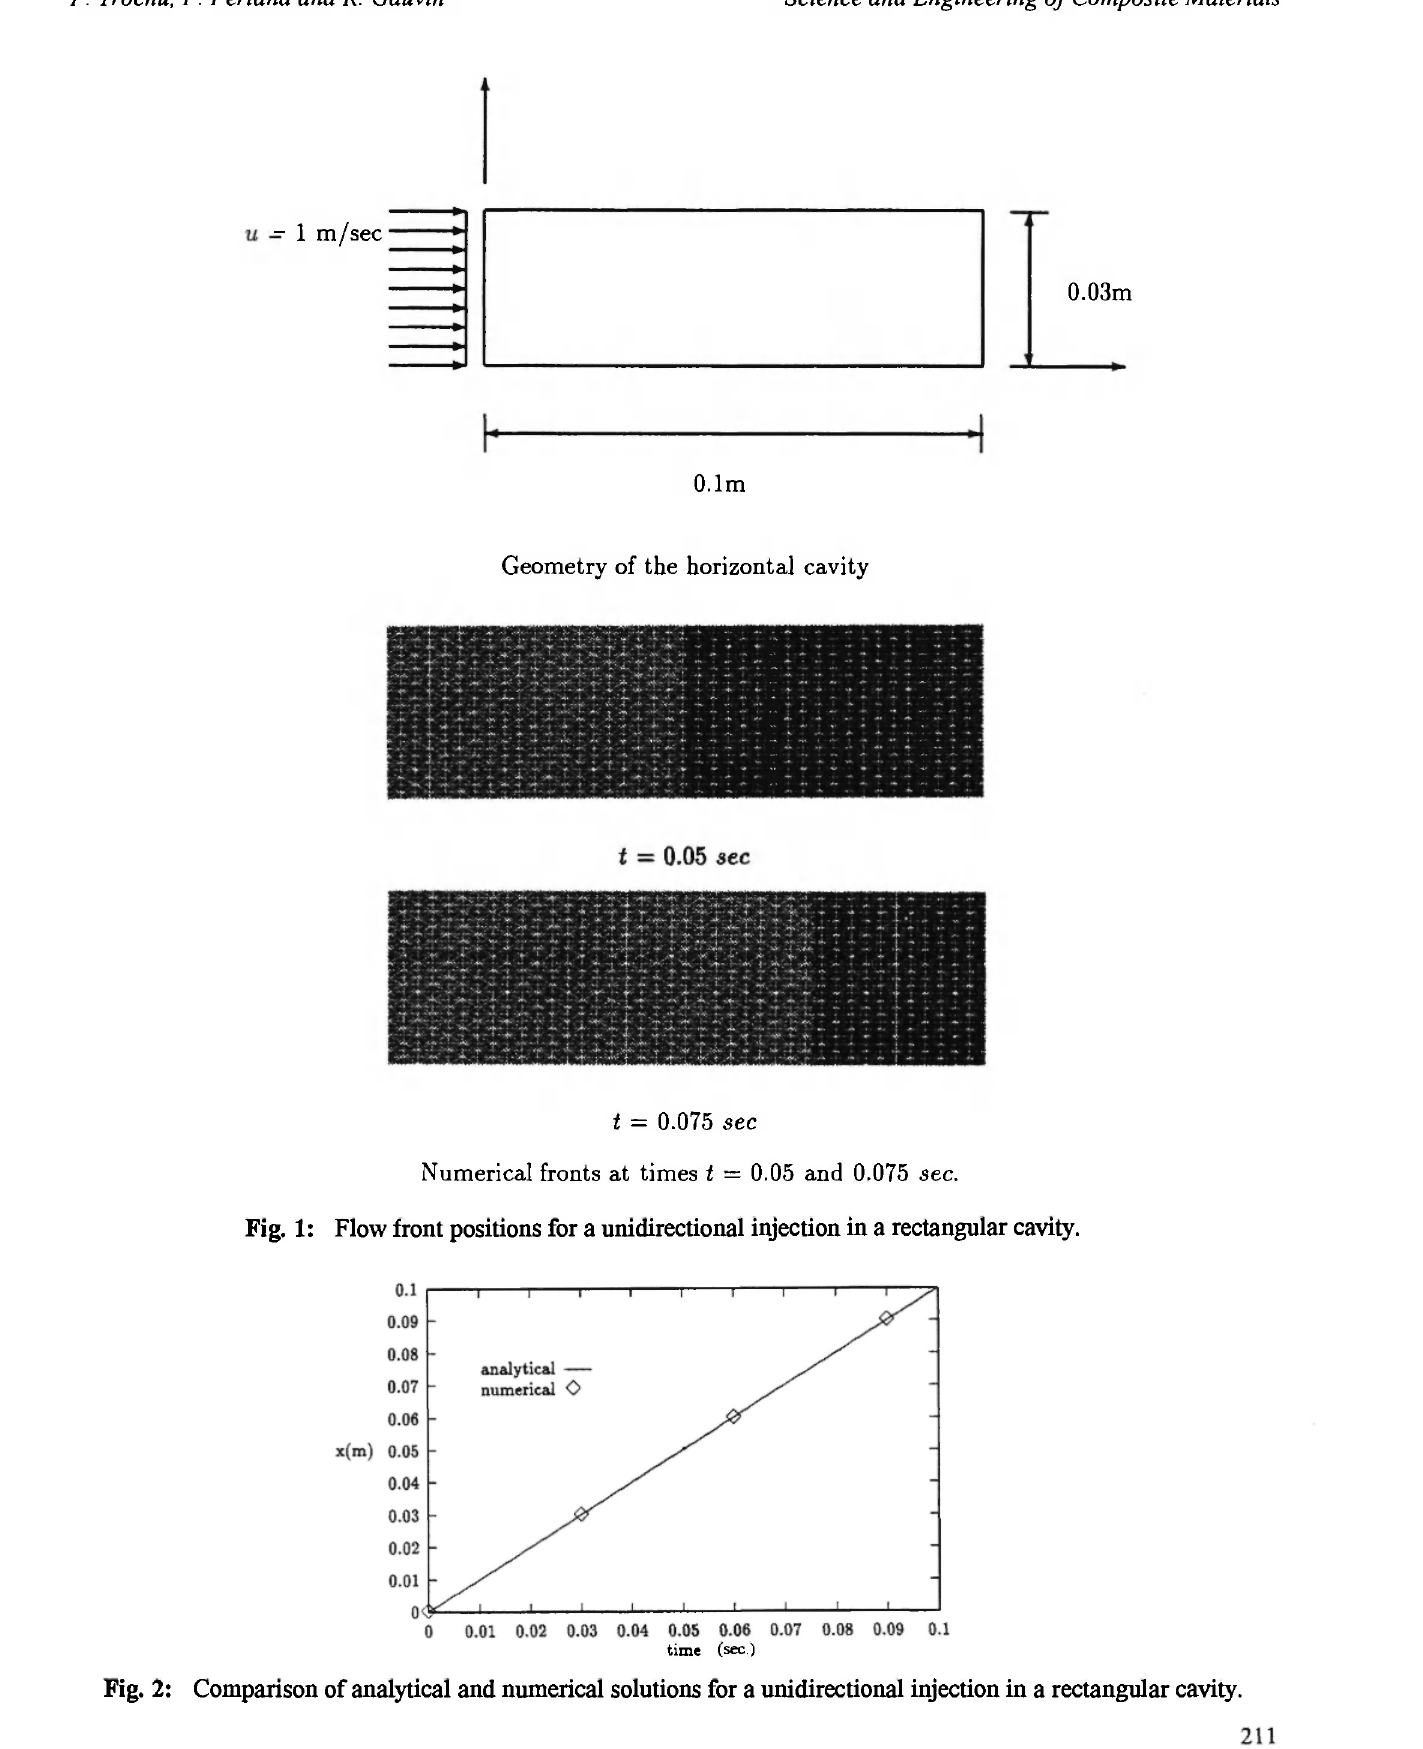
Fig. 1: Flow front positions for a unidirectional injection in a rectangular cavity.